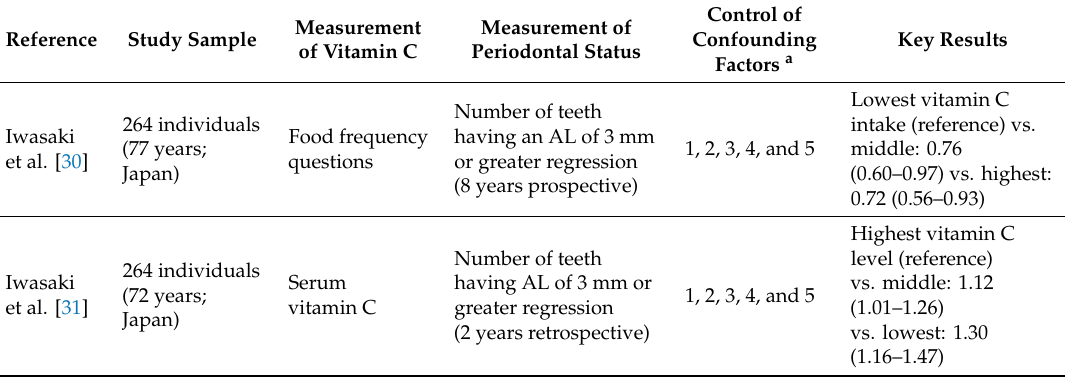
Table 8. Summary of cohort studies on the relationship between of vitamin C and periodontal